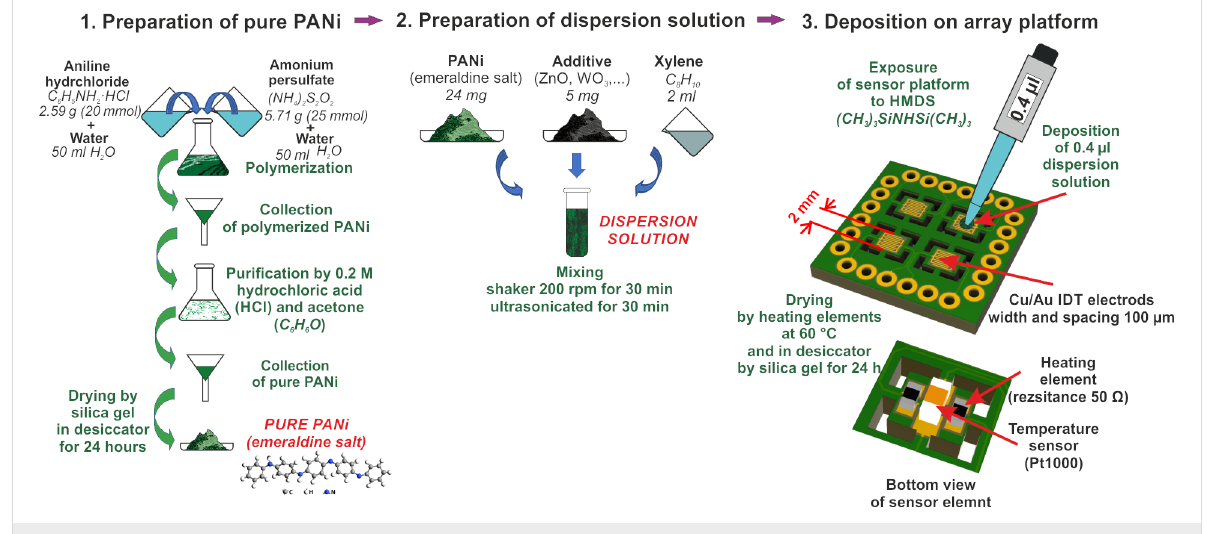
Figure 13: Sensor array